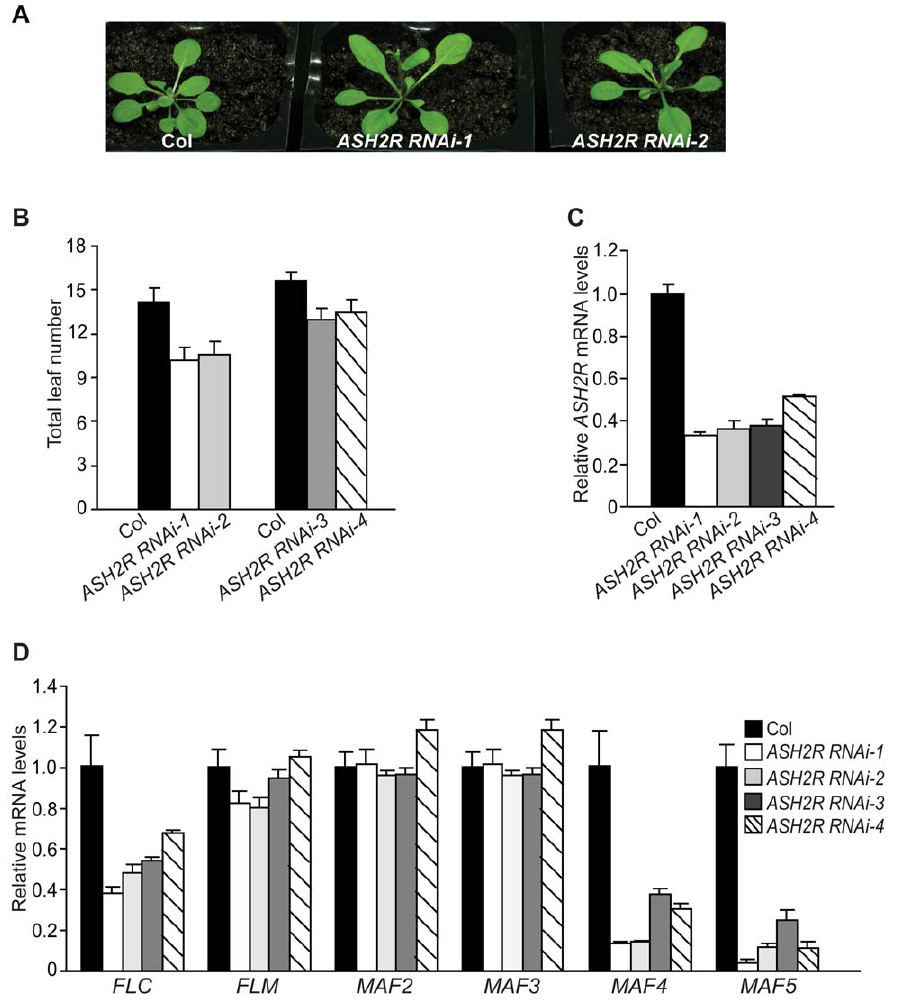
Figure 3. ASH2R Knockdown Causes Early Flowering. (A) Phenotypes of ASH2R RNAi lines grown in LD. (B) Flowering times of the ASH2R RNAi lines grown in LD. Total leaf number for each line (12 plants per line) was counted. Error bars indicate SD. (C) Relative ASH2R mRNA levels in ASH2R RNAi seedlings determined by real-time quantitative PCR. Relative expression to parental Col is presented. Bars indicate SD. (D) Relative mRNA levels of FLC and FLC homologs in ASH2R RNAi seedlings determined by real-time quantitative PCR. Bars indicate SD.